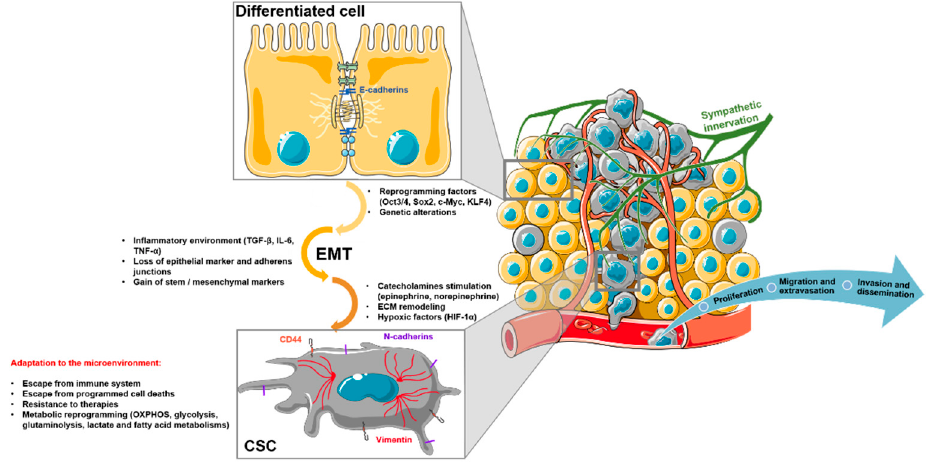
Figure 1. Tumor microenvironment drives epithelial-to-mesenchymal transition and tumor pro- gression. Under the effects of genetic alterations and/or the influence of the microenvironment (inflammatory cytokines, hypoxic factors, catecholamines), differentiated tumor cells can undergo epithelial-to-mesenchymal transition and metabolism reprogramming. These alterations lead to the development of cancer stem cells that escape programmed cell death, evade the host immune system, and resist standard care chemotherapies. ECM: extracellular matrix; CSC: cancer stem cell; EMT: epithelial ‐ to ‐ mesenchymal transition; OXPHOS: oxidative phosphorylation.